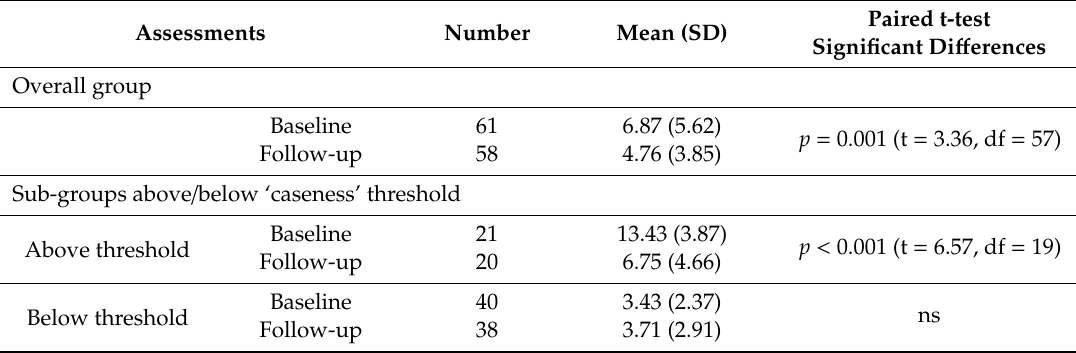
Table 2. GAD-7-assessed anxiety scores for whole group and for sub-groups above the ‘caseness’ threshold ( ≥ 8) and below the threshold ( < 8) at baseline and 6-month follow-up with paired t-test significant di ff erences.